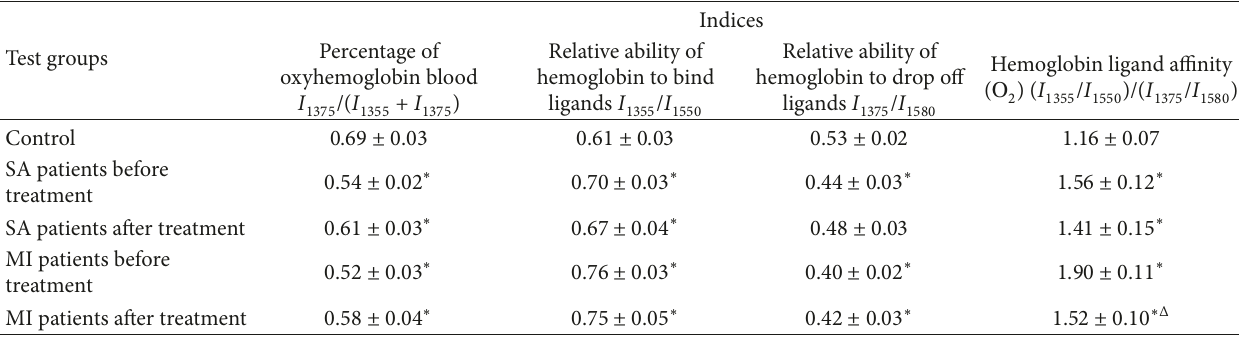
Table 3: Correlation of Raman bands of erythrocyte hemoglobin hematoporphyrin of apparently healthy people and people with SA and MI before and after treatment, 𝑛 = 20 ( V ±